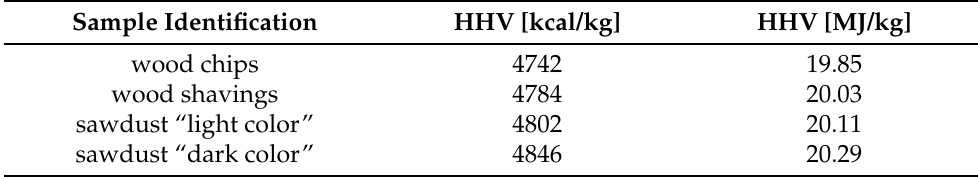
Table 2. Higher Heating Value (HHV) of different particle sizes (determined in